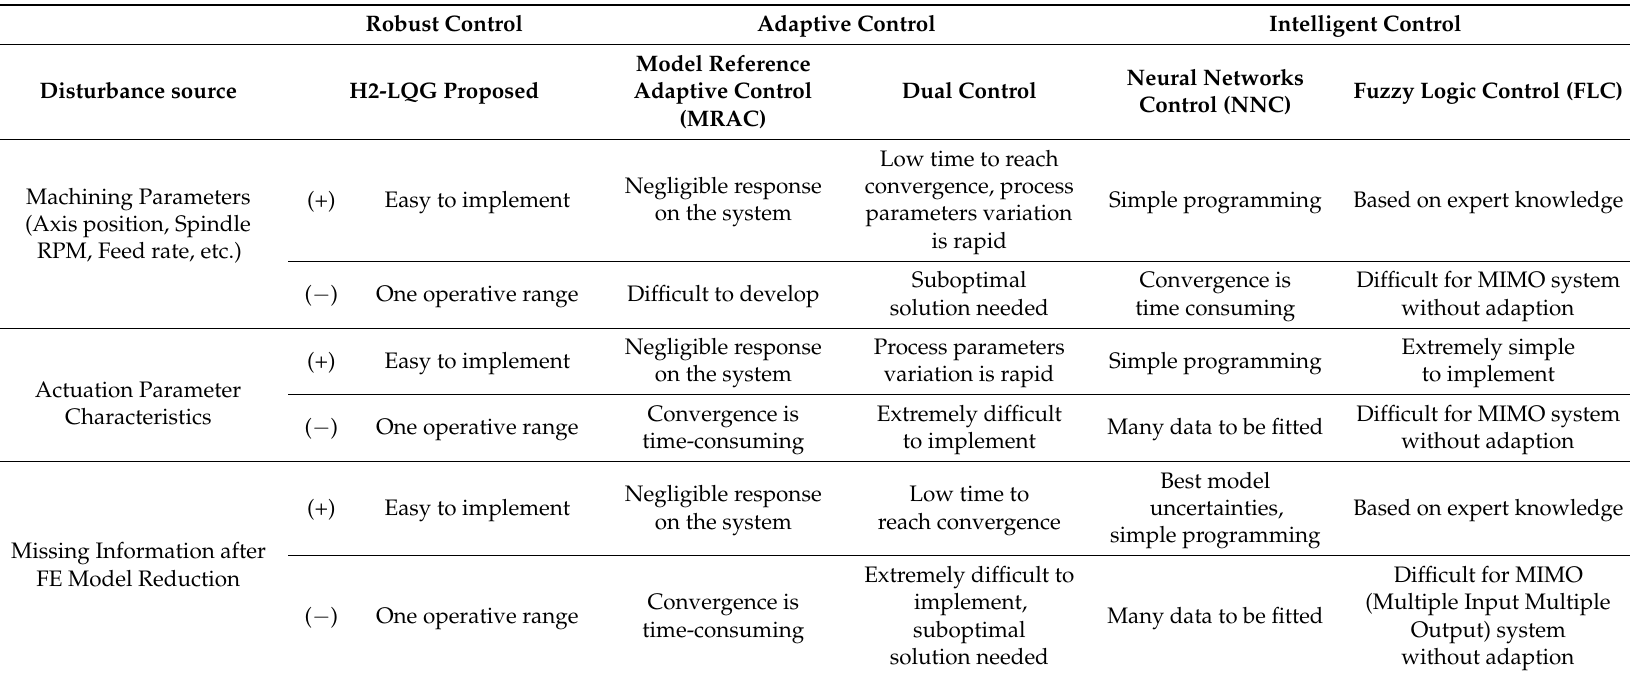
Table 6. Trade-off comparison of different control approaches (advantage (+)/disadvantage